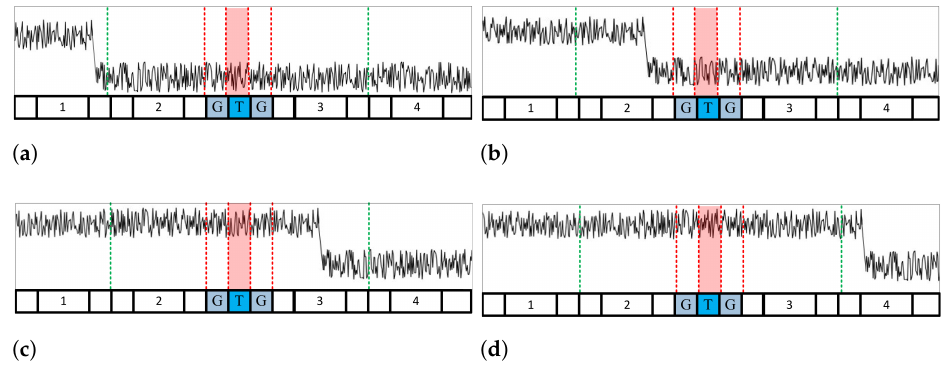
Figure 4. A case where a window is determined as a clutter edge environment: clutter edge is located